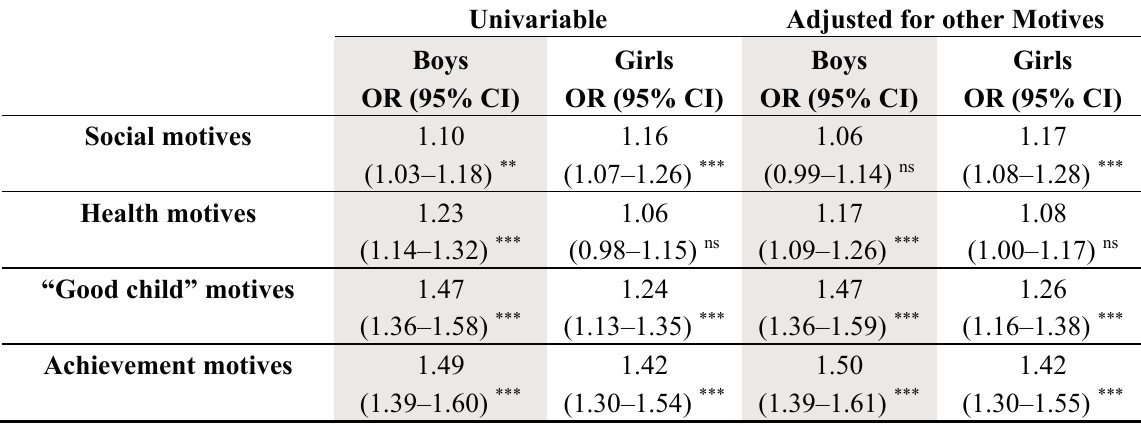
Table 2. Associations between motives for PA and sufficient PA (on 7 days per week) adjusted for age: Odds ratios (OR) and 95% confidence intervals (95% CI) from binary logistic regression (crude and adjusted) by